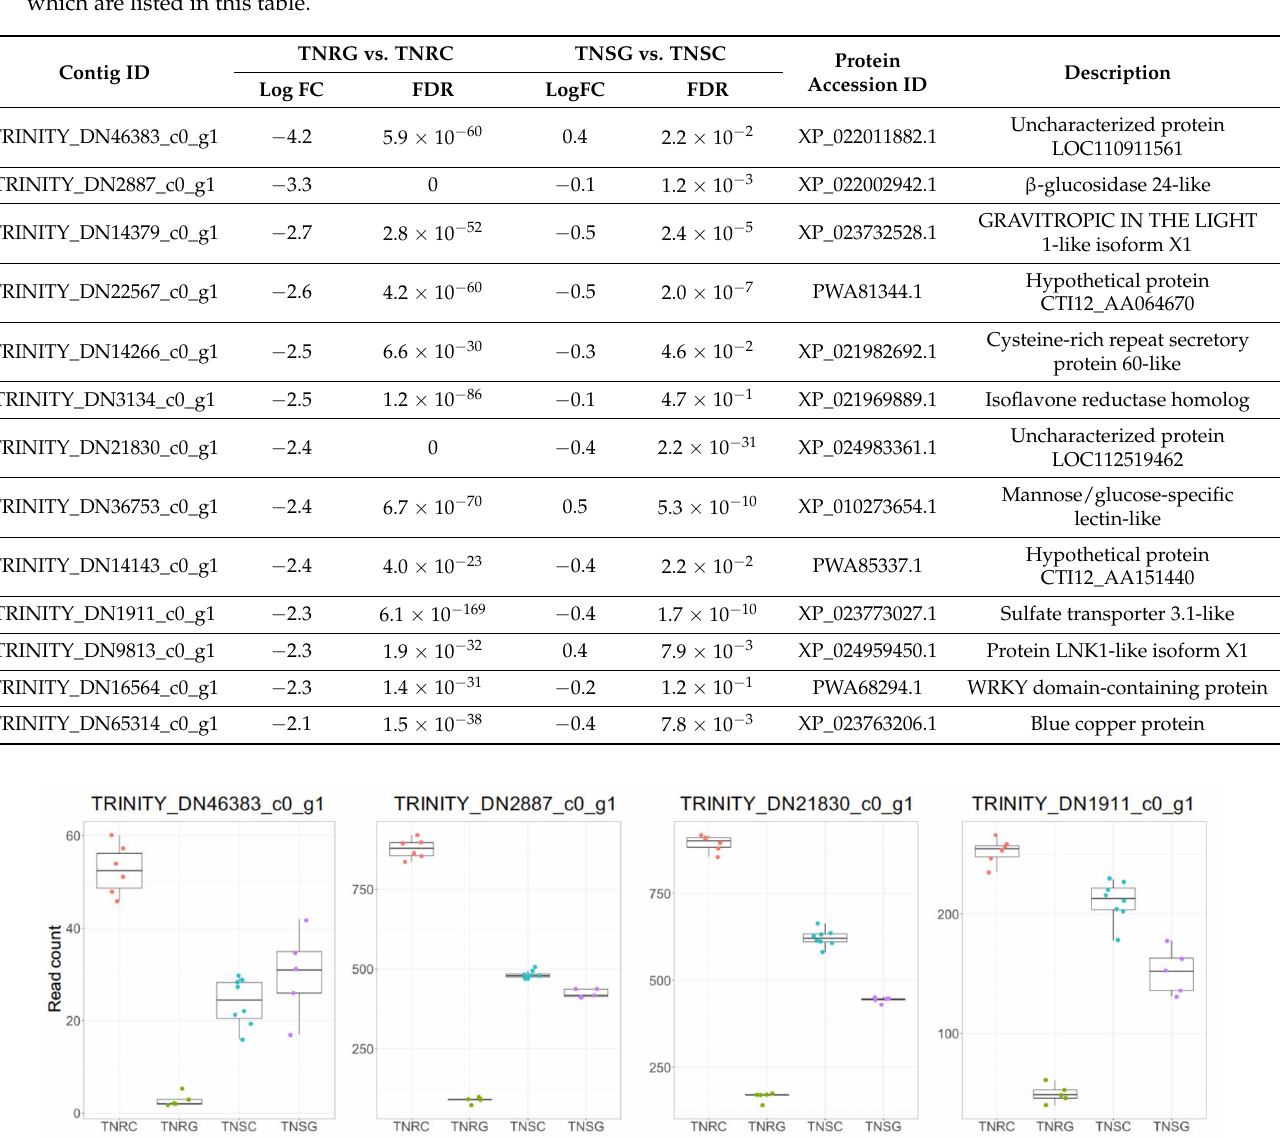
Table 7. Gene list of downregulated genes only in TNRG. These genes were downregulated in TNR but not in TNS after glyphosate treatment (FDR < 0.05). Twenty-six genes were filtered by removing the gene expressed with small read counts (<20) from 97 downregulated genes only in TNR. Of these genes, 13 genes had corresponding protein accession numbers, which are listed in this table.